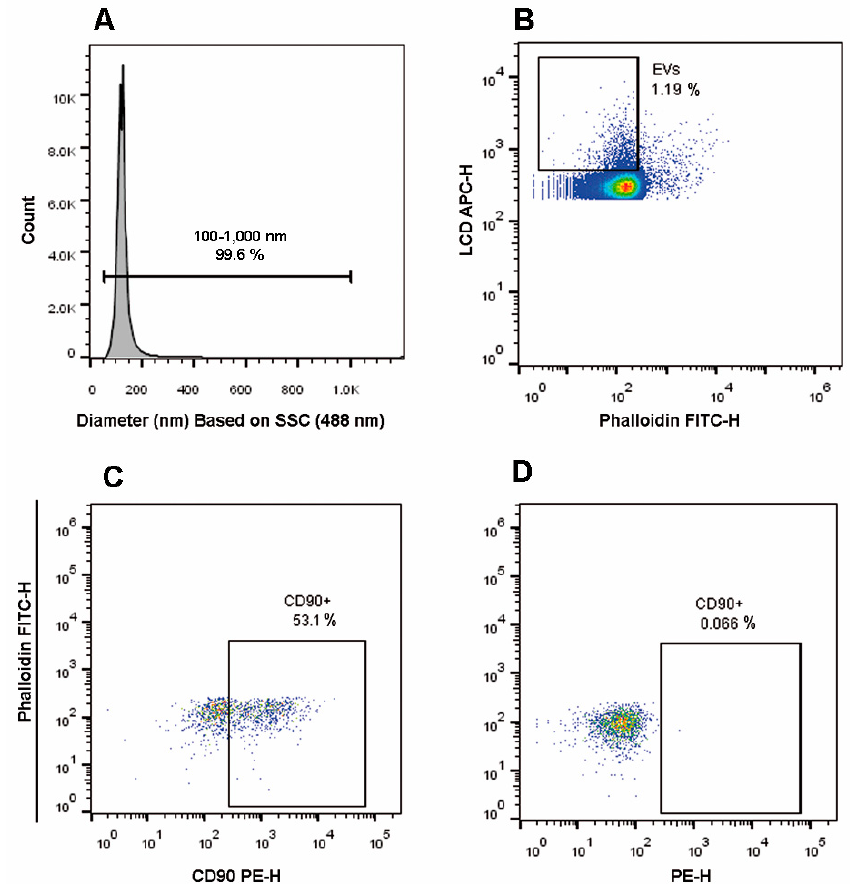
Figure 4. MSC-derived EV analysis. ( A ) The size of events was obtained by transforming .fcs files through the Rosetta Calibration system. The size of EVs was represented as a histogram and a gate covering EV dimensions was drawn (100–1000 nm). ( B ) Events displaying a diameter in the range 100–1000 nm were then analyzed on a Phalloidin FITC-H / LCD-H dot-plot and LCD +/ Phalloidin- events were identified as EVs. ( C ) EVs were analyzed for their positivity to CD90 expression: ( D ) the dot-plot represents the FMO for CD90. The figure is representative of at least three separate experiments.